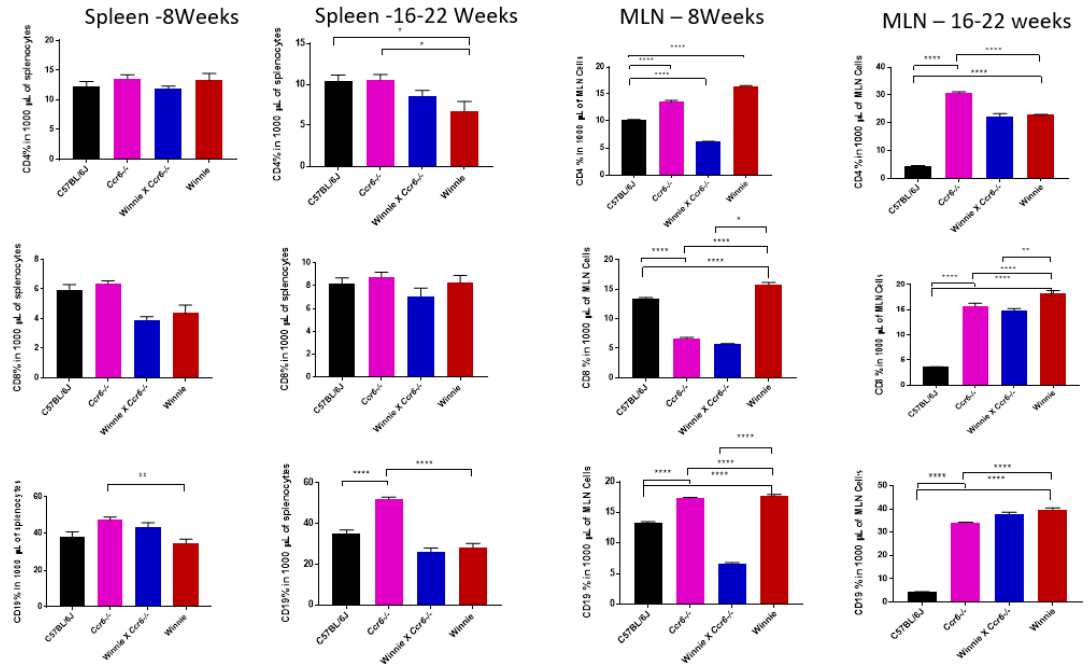
Figure 8. Comparison of CD4, CD8 and CD19 distribution in the spleen and MLN in the four genotypes at 8 weeks of age and 16–22 weeks of age by flowcytometry. No significant di ff erence seen among the genotypes in the CD4% and CD8 lymphocyte % in the spleen with an increase in CD19% in the Ccr6 -deficient models at 8 weeks although significant di ff erences existed in the surface markers in the MLN. A trend of marked decline in all the surface marker percentages tested was seen in Winnie × Ccr6 − / − , also as intermediate to that of the healthy control and Winnie in both the spleen and MLN. n = 7 per group. Data expressed as Mean ± SEM by one-way analysis of variance (ANOVA) and Tukey’s multiple comparison test. ** p < 0.01, **** p < 0.0001.